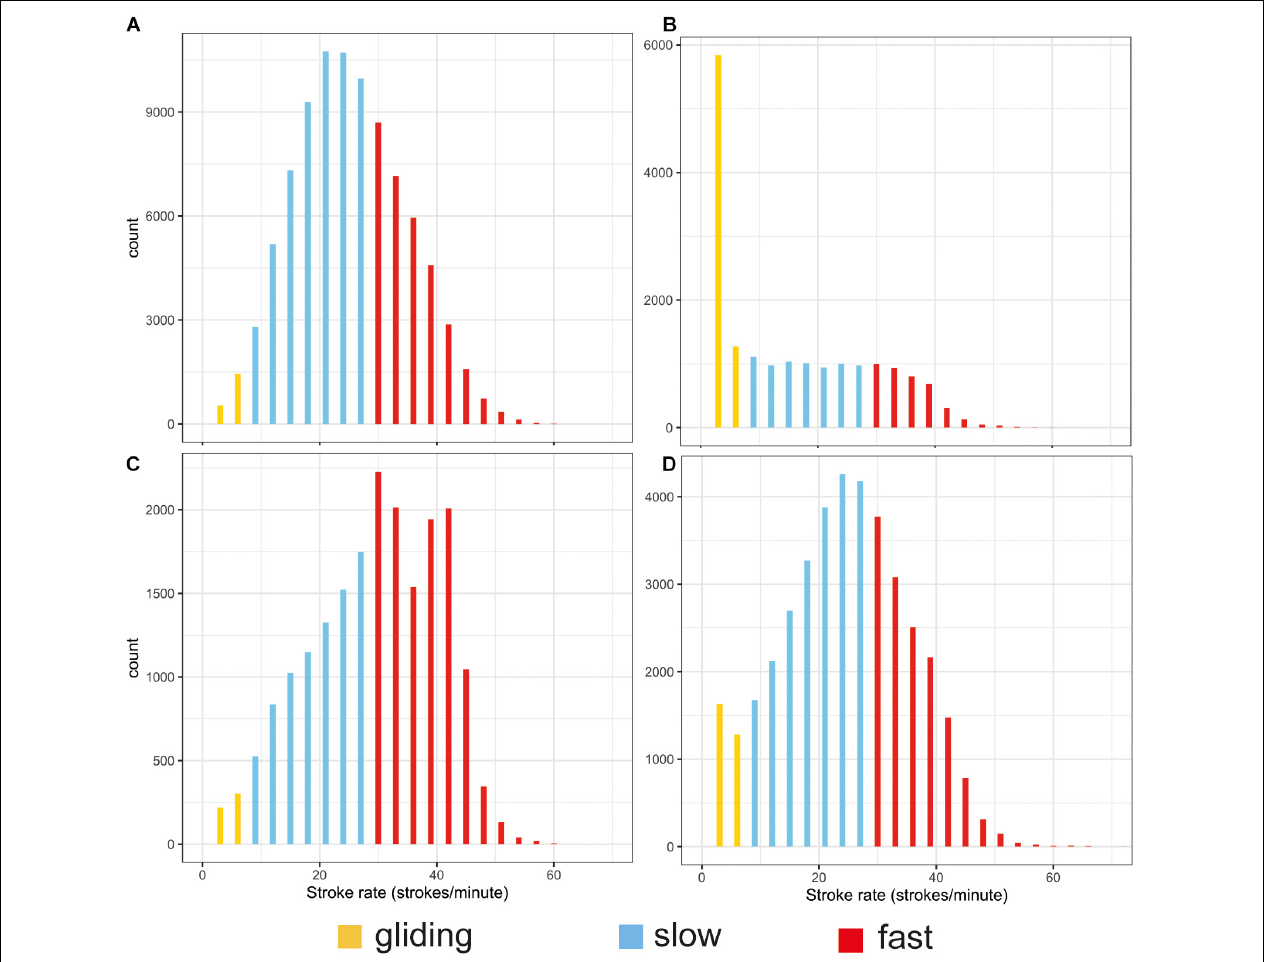
FIGURE 4 | Histograms of the distribution of stroking rates during surface periods (A) and the descent (B) , ascent (C) , and bottom (D) phases of all dives. The different colors indicate gliding 0–6 strokes/min (yellow), low-rate stroking 7–26 strokes/min (blue) and high-rate stroking > 27 strokes/min (red). Note the different scales on the y